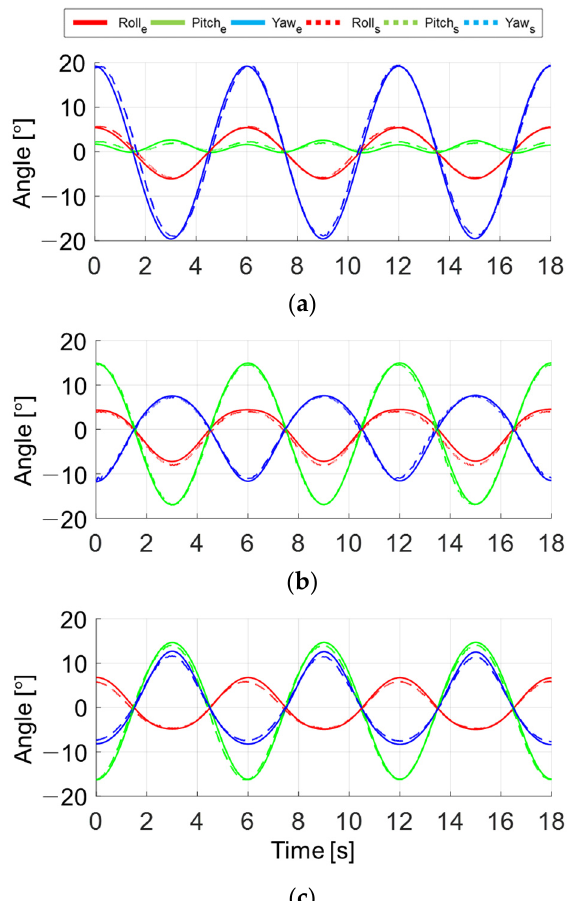
Figure 6. Results of the motion control experiment. The roll, pitch, and yaw denote the Euler angle of handle rotation. The subscript e and s denote the values measured and estimated from the kinematic model, respectively; ( a – c ) are the results for the joint 𝑖 = 1 , 2, and 3, respectively.